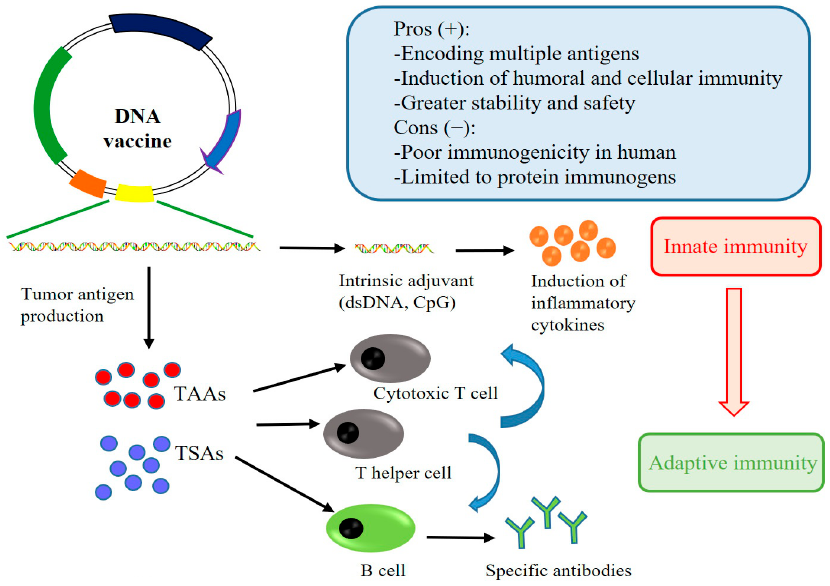
Figure 1. A scheme for the mechanisms of immune activation by DNA vaccines. An effective immunity induced by the specific CD8+ T cell has an essential role in the antitumor activity, and DNA vaccines are powerful at inducing CD8+ T cell responses [23]. Just two cancer vaccines are currently approved for human application (Sipuleucel T and T-VEC). Sipuleucel-T (Provenge) was the first dendritic-cell-based cancer vaccine ap- proved by the U.S. Food and Drug Administration (FDA) for the control of prostate can- cer, and T-VEC (talimogene laherparepvec) was the first oncolytic virus vaccine for the treatment of patients with melanoma [24–26]. Notably, an interesting preclinical study demonstrated that a genetically engineered DNA vaccine induced highly antitumor effi- cacy and decreased the tumor nodules in a mouse lung cancer model [27]. Although DNA vaccines are shown to elicit therapeutic antitumor immune responses, the DNA vaccines for lung cancer are still in the clinical trial phases. In this context, new developments in DNA plasmid delivery and optimization will improve the efficacy of DNA vaccines in clinical studies to achieve the goals of translational applications in patients. 3. Potent Antigens Selection for Lung Cancer The most vital process in the development of DNA vaccine for lung cancer is to select the potent tumor antigens. These antigens are homogenously expressed in the cancer cells and are designed to prevent tumor immune escape and cancer metastasis. Additionally, the antigens are highly immunogenic and are indispensable for cancer cell survival [28]. To the best of our knowledge, tumor antigens are divided into two major categories, in- cluding tumor-associated antigens (TAAs) and tumor-specific antigens (TSAs) [29]. For example, many TAAs are monomorphic self-antigens, which are expressed in both cancer cells and normal host cells. TSAs (neoantigens) are encoded by tumor-specific somatic mutations and are particularly expressed in neoplastic cells [30]. In the past few years, it was extensively investigated that TAAs showed less clinical benefit because of the preexisting central tolerance to self-antigens [28]. Especially, target- ing TAAs (MAGE-A3, MUC-1) in lung cancer induced inefficient immune response in the phase III trials [31]. In contrast to TAAs, TSAs are less likely affected by central or periph- eral tolerance due to molecular alterations [32,33]. TSAs are easily generated because of the genomic instability presented in lung cancer, and are effectively identified by immune system of the host [30]. Thus, the generation of TSAs will contribute to designing tumor